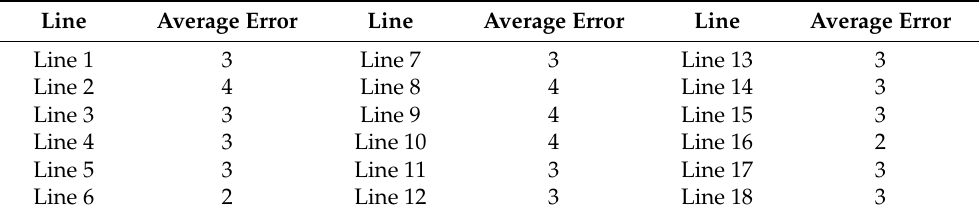
Figure 19. The vertex of diamonds located on vertical lines of squares. The difference between the line that connected vertical lines of squares and the vertex of diamonds are shown as calibration errors. Table 3 depicts pixel error between vertical lines of squares and diamonds. Table 3. Vertical lines of squares, the vertex of diamonds, and error.